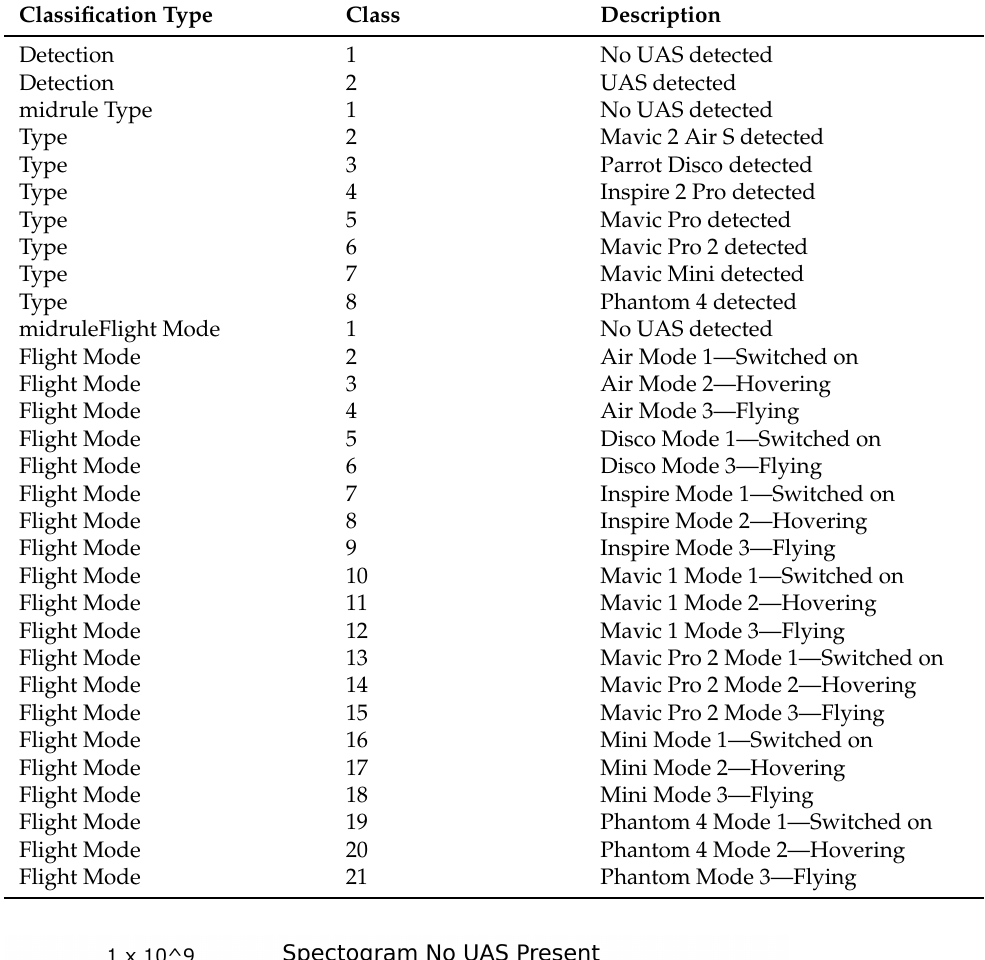
Table 2. UAS Classes.